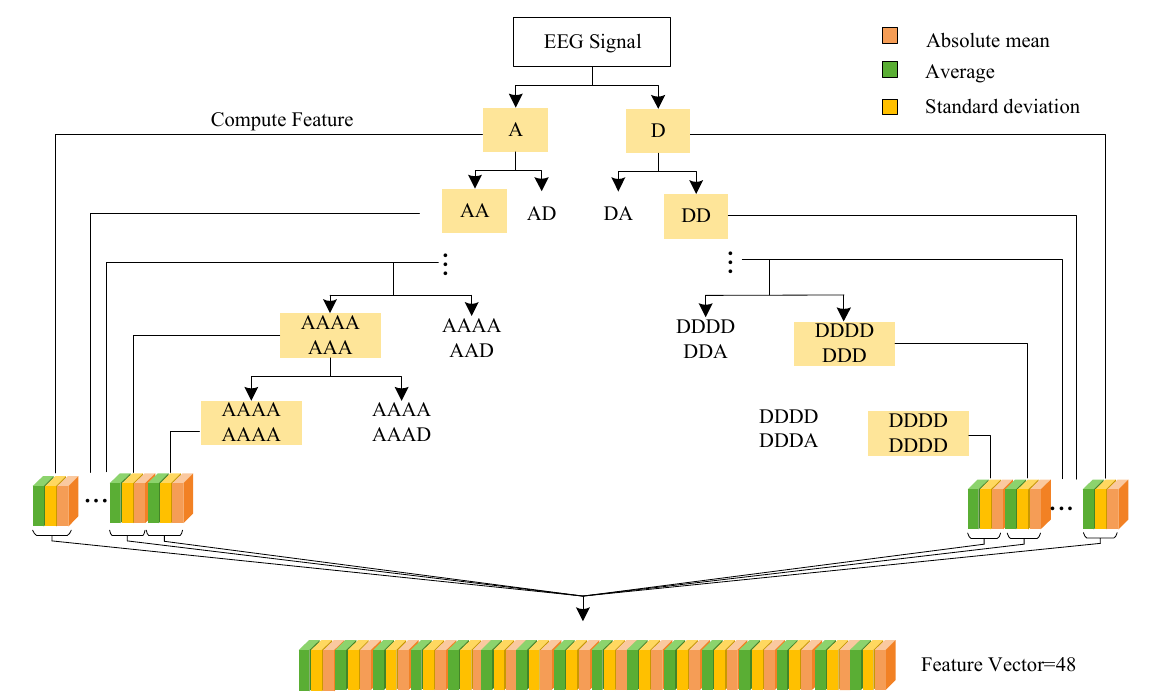
Figure 4. Statistical feature extraction process from the raw EEG